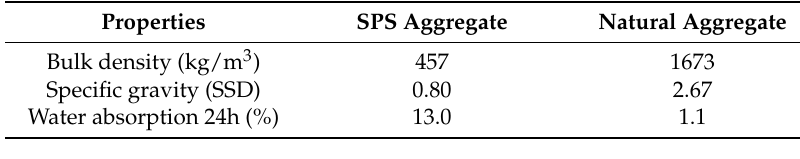
Table 2. Characteristics of natural and SPS aggregates.